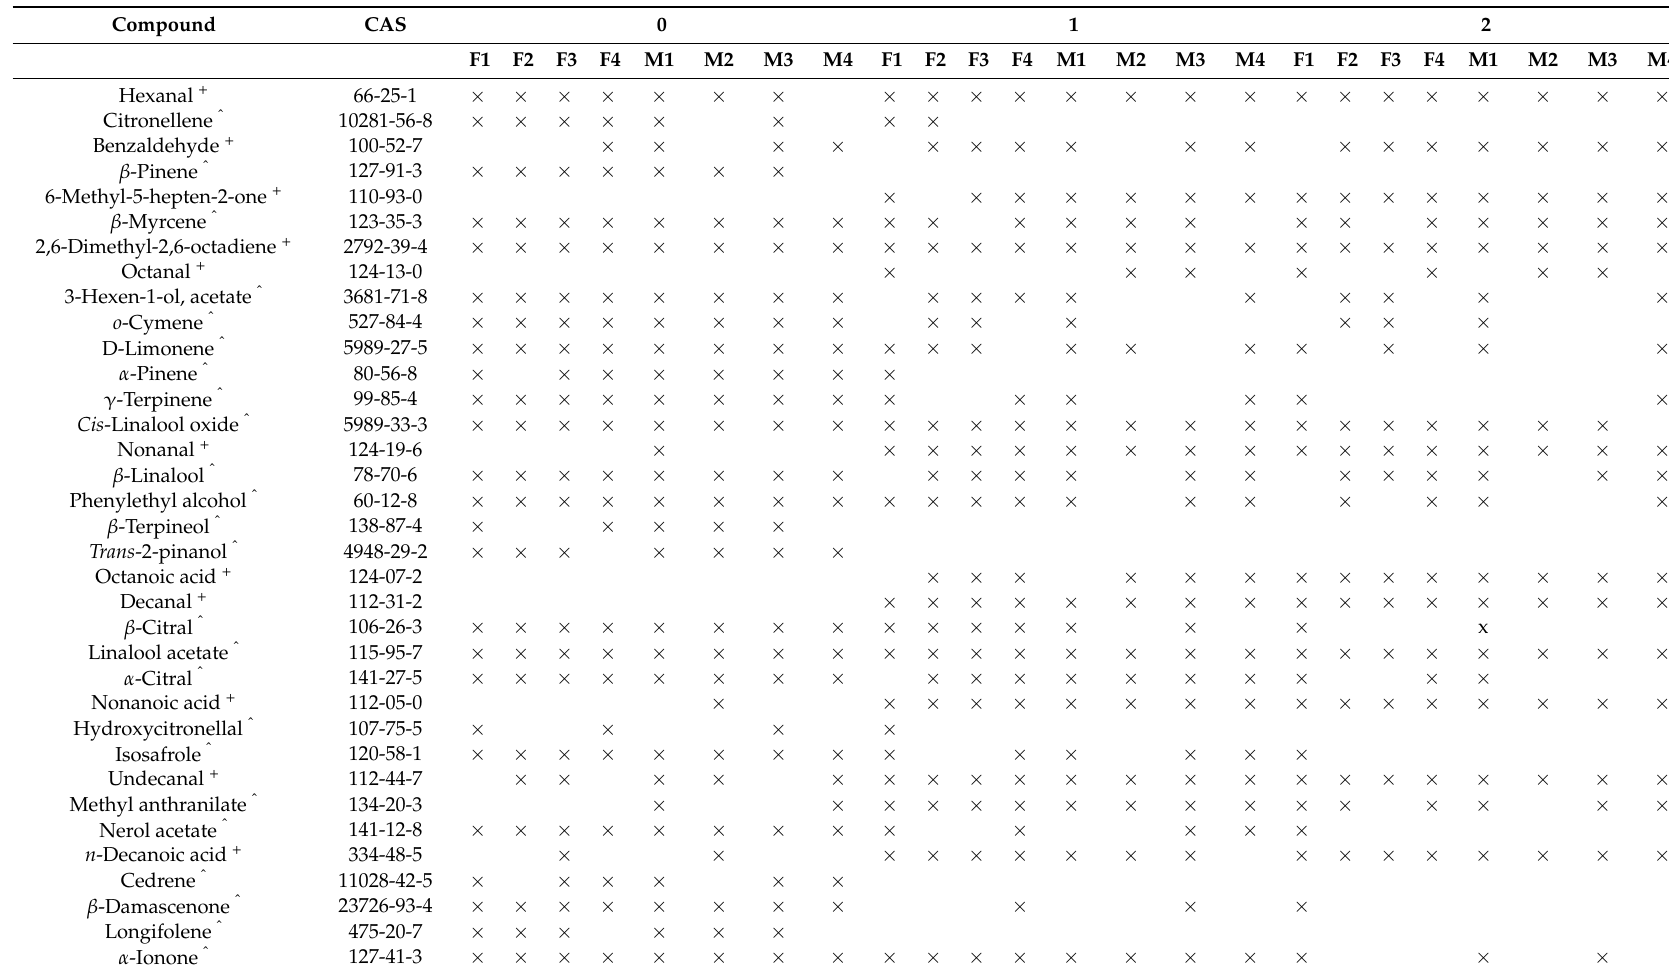
Table 2. Compounds identified in the skin headspace of human participants 0, 1, and 2 h after fragrance application. Samples were collected using headspace solid-phase microextraction (HS-SPME) in a wearable format followed by thermal desorption to gas chromatography-mass spectrometry (GC-MS). Compounds are shown in order of increasing retention time, where × indicates the presence of a compound in a sample. (F—female,